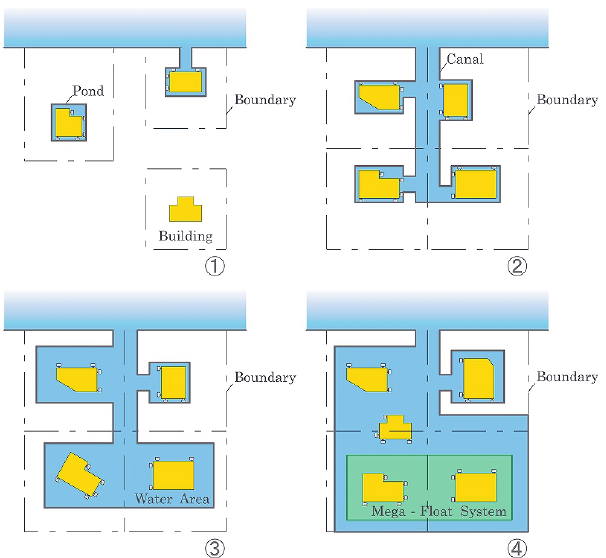
Figure 3. Final view of the floating platform in the man-made reservoir.